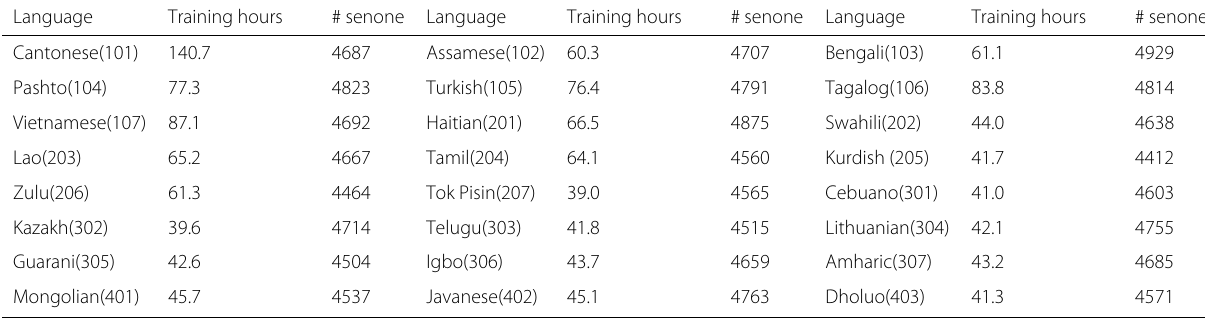
Table 1 The corpus size and number of senones of the Babel languages